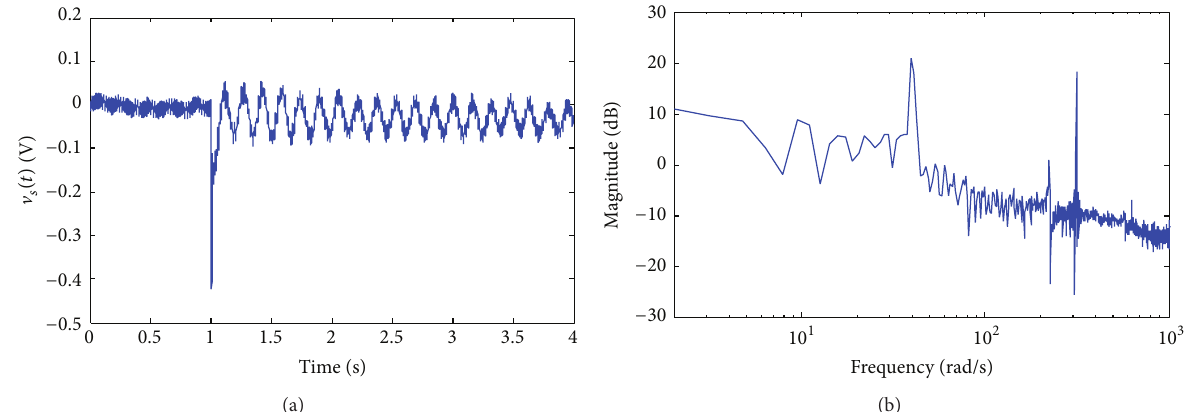
Figure 4: Experimental system’s responses: (a) pulse response and (b) frequency response function.